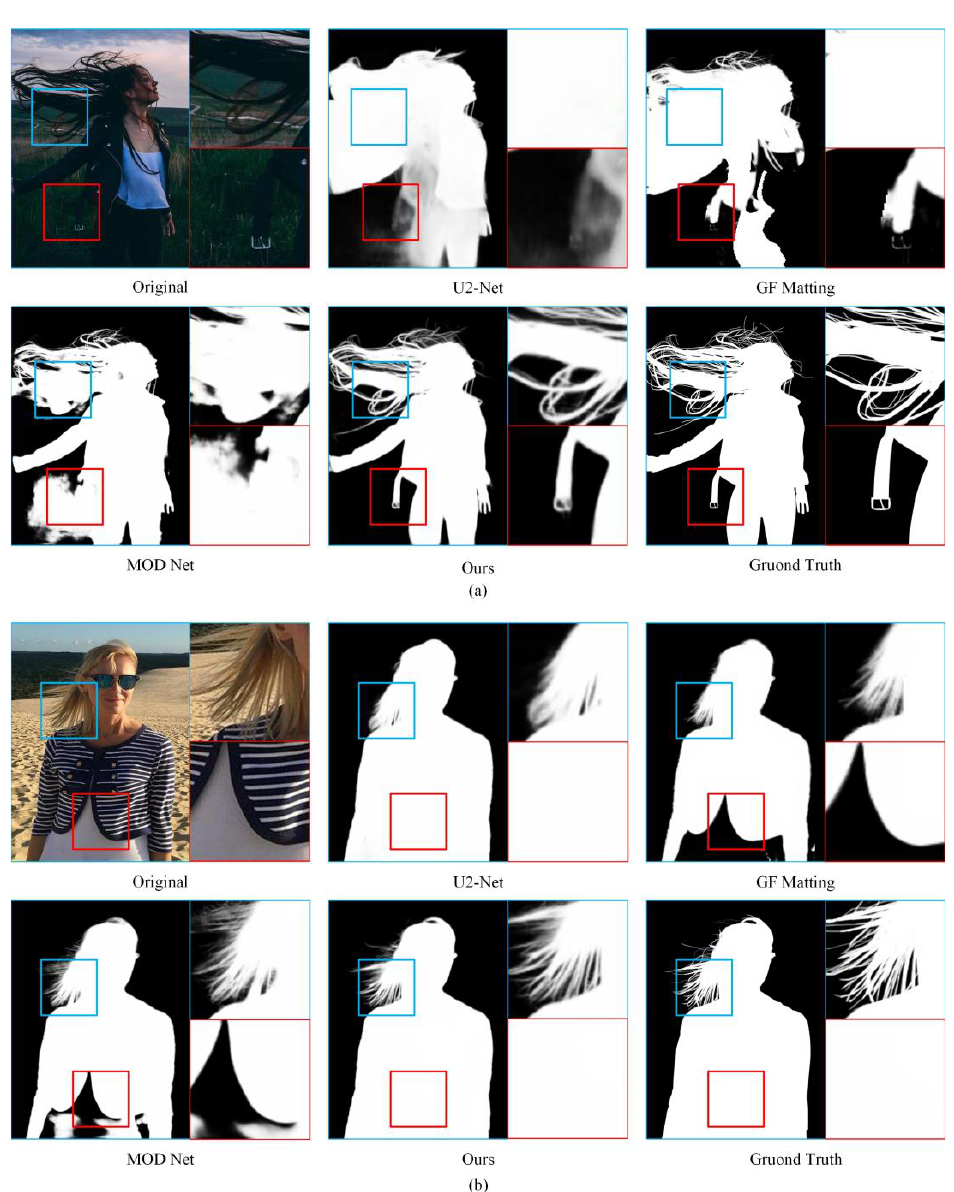
Figure 7. RealWorldPortrait-636 test set experimental results: ( a ) Chart 612 in the dataset; ( b ) Chart 295 in the dataset.